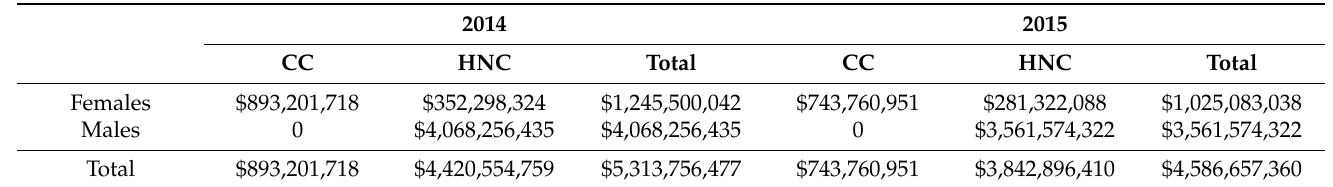
Table 2. Aggregated direct medical cost of newly diagnosed cancers in the National Health Insurance Research Database in a single year (NTD).